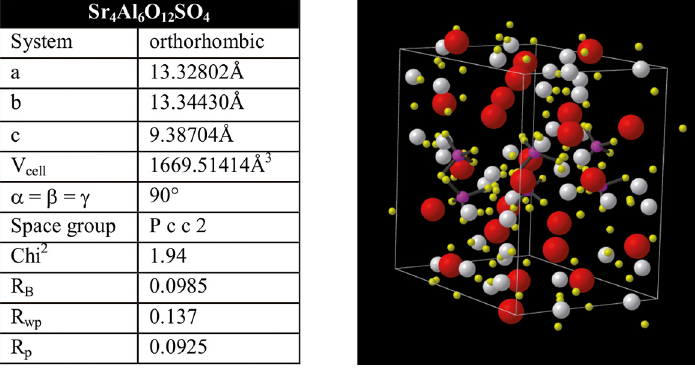
Figure 7: Representative scheme of the strontium compound (Sr4Al6O12SO4) crystal structure and crystallographic